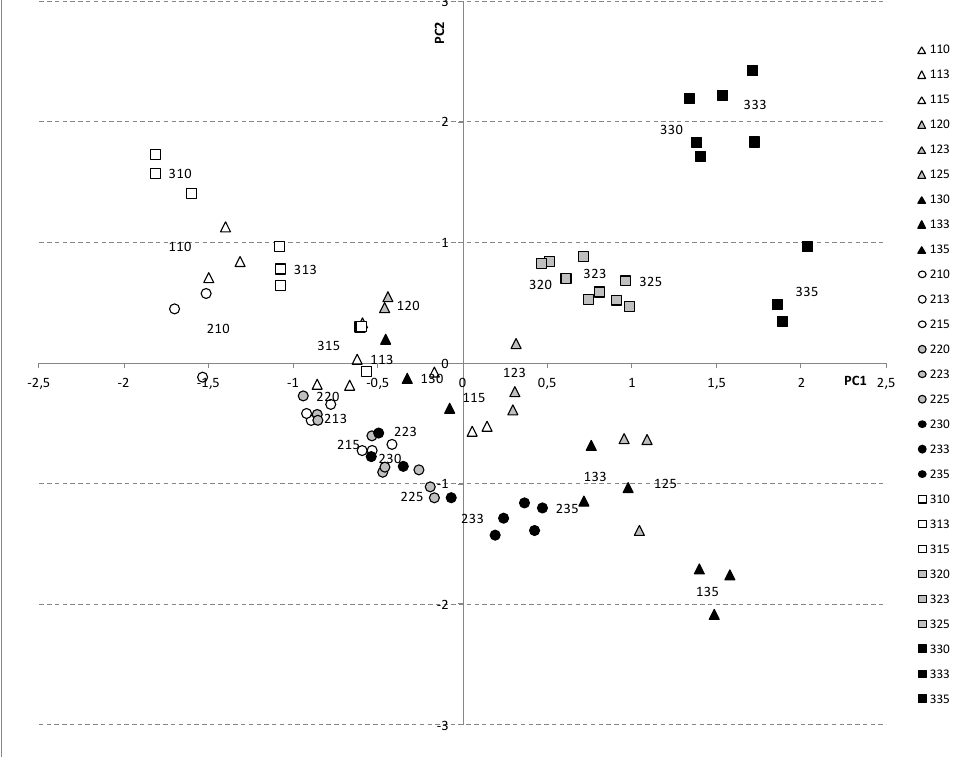
Figure 11. Samples in the PCA plane (PC1: 67.2% of total variance; PC2: 11.9% of total variance) for apricots. Symbols represent the three cultivars: ‘Spring Blush’ (Δ), ‘Robada’ ( ○ ), and ‘Kyoto’ (□). Harvest day −6 (white symbols), harvest day −3 (grey symbols), and harvest day 0 (black symbols).